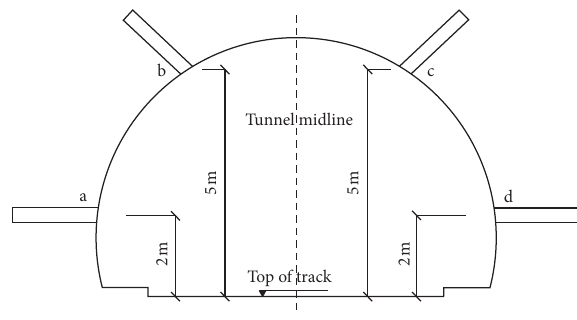
Figure 5: Hole layout.